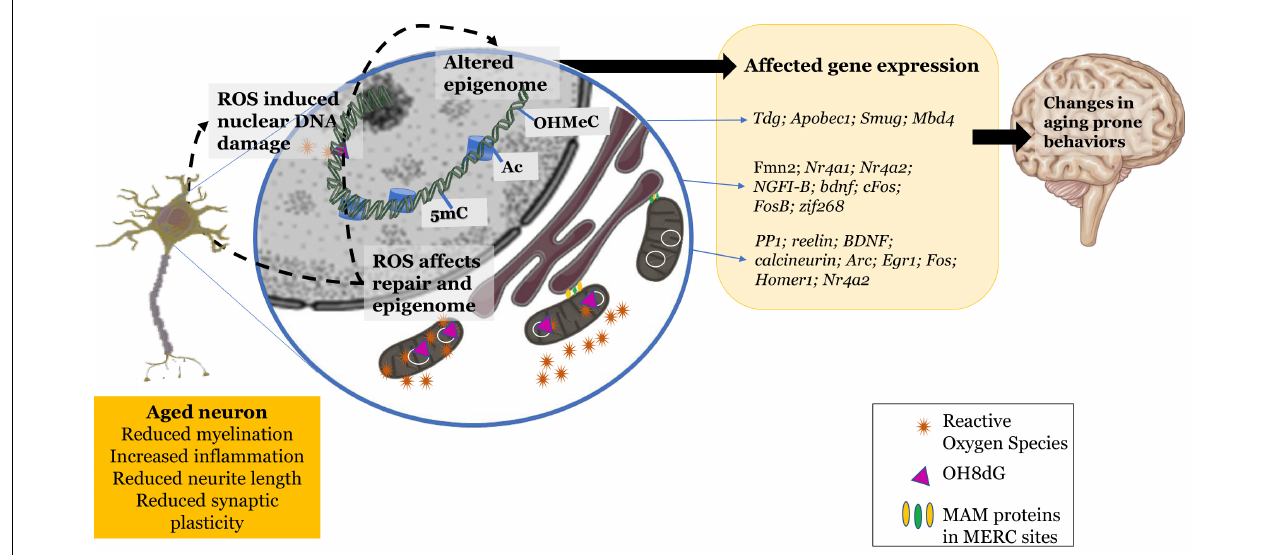
FIGURE 1 | Changes exhibited by the aging neuron: increased reactive oxidant species production, mitochondrial and nuclear DNA damage, dysfunctional mitochondrial-endoplasmic reticular sites. These changes in the redox environment in the cytosol as well as nucleus trigger epigenetic changes leading to altered gene expression and further leading to changes in aging prone behaviors. Schematic parts of the figure were taken from Servier Medical art (https://smart.servier.com/) licensed under an Unported license of Creative Commons Attribution